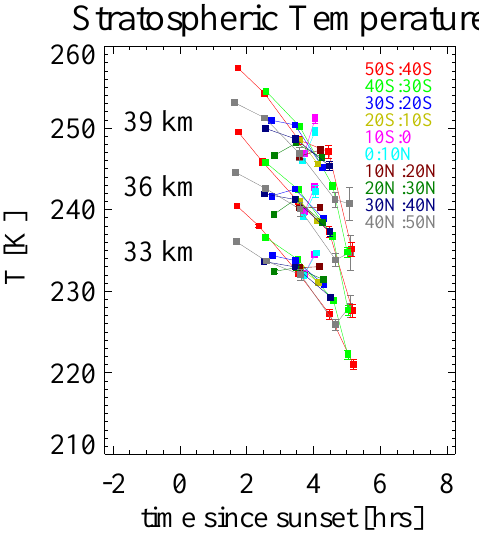
with the estimated 1 σ error indicated as a dot-dashed black line.